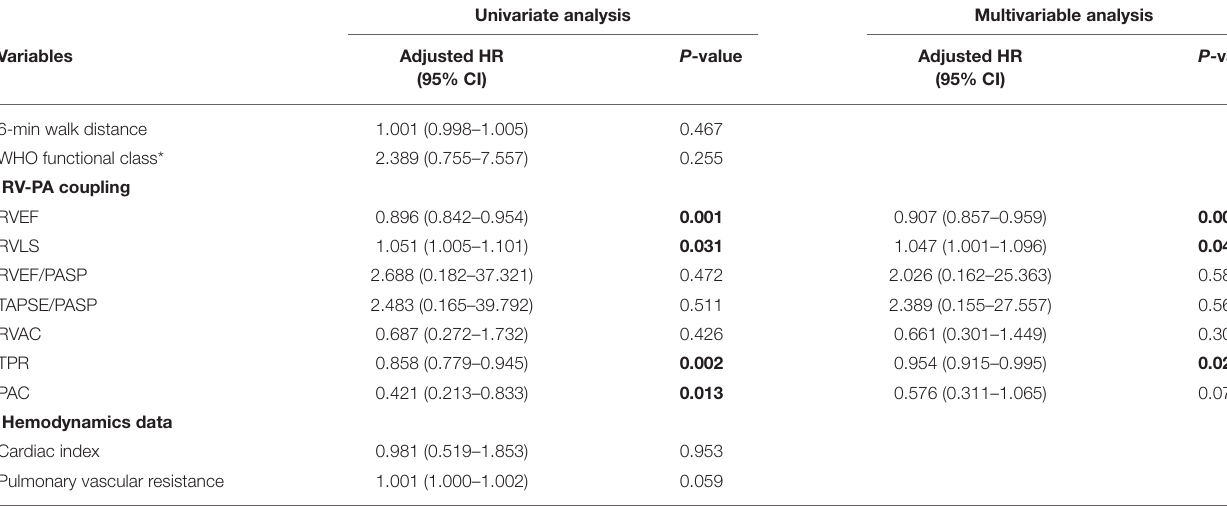
TABLE 4 | Cox regression analysis of factors predictive of adverse clinical outcomes in precapillary PH patients after adjustment for age, sex, and BSA. Univariate